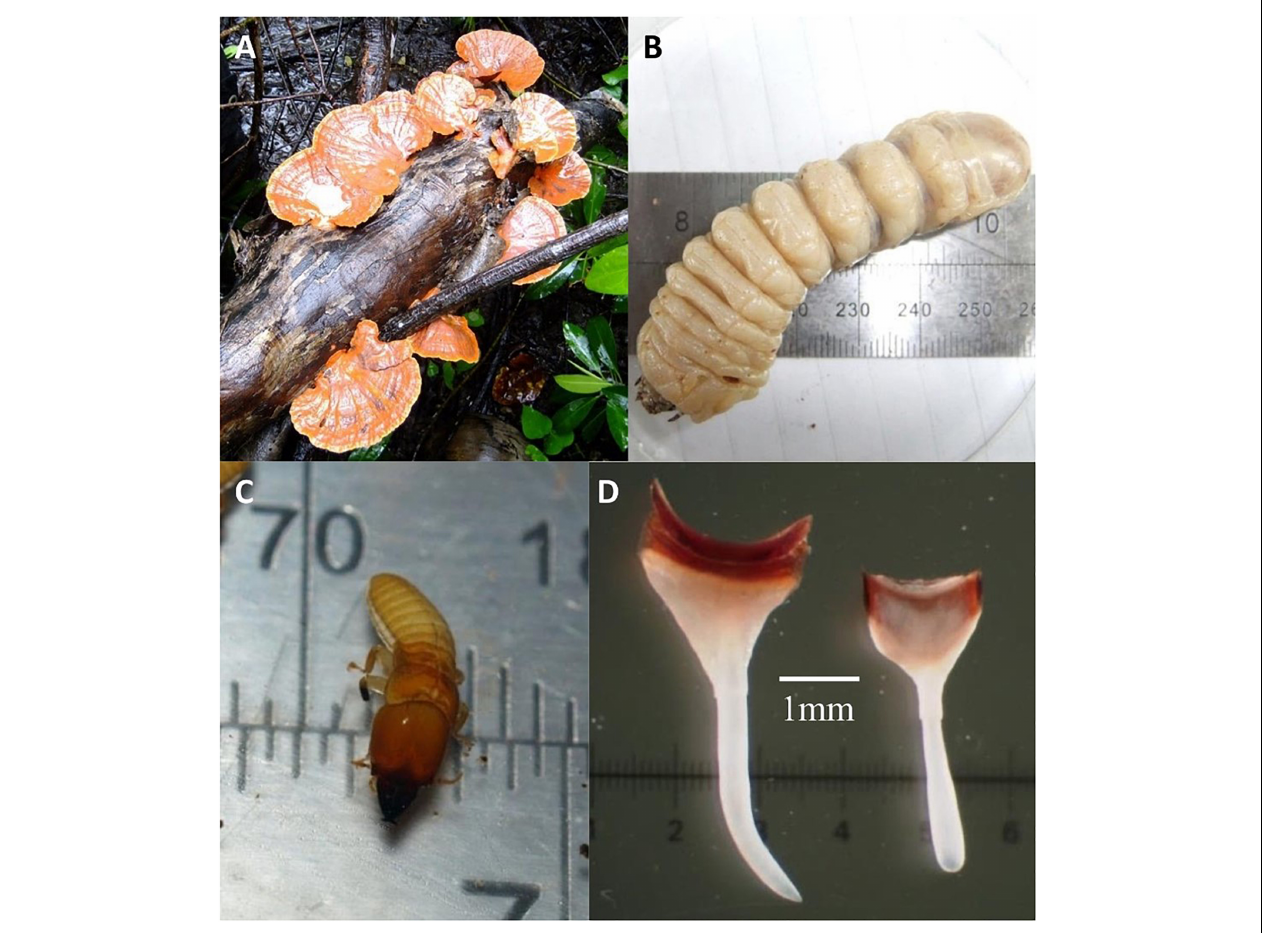
FIGURE 3 | Wood degrading organisms found in mangrove forests of Kaledupa Island, Indonesia. (A) The bracket fungi, Pycnoporus sanguineus on a fallen Xylocarpus sp. tree in the Galua forest; (B) a beetle larva of the family Cerambycidae from the Galua forest; (C) frequently found in decaying mangrove wood, the termite Cryptotermes from the Galua and Laulua forests; (D) teredinid pallets belonging to Lyrodus massa removed from experimental wooden panels in the Langira mangrove